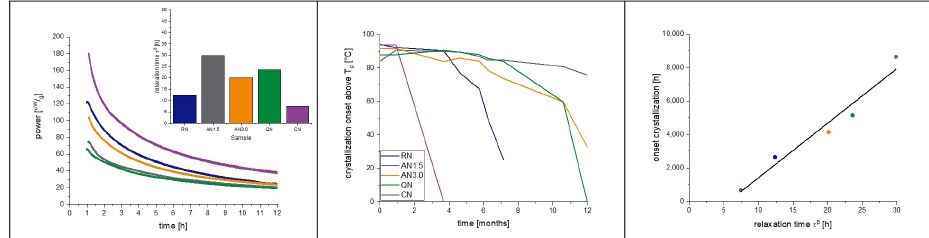
Figure 9. Samples from the 2 mgmL_1.6PS_Suc formulation at 25 °C; correlation of crystallization with α-relaxation, and the effect of the freezing step. The left picture presents a zoomed in area of the IMC measurement to focus on the relaxation curves, which are converted to a τ β -value. The middle graph shows the crystallization onset of the samples at 25 °C determined with DSC measurement using the onset of crystallization above T g . On the right, the correlation of relaxation time with crystallization onset is presented. The correlation coefficient of the fit is r 2 = 0.94. Random nucleation (blue), additional annealing step of 1.5 h (grey), additional annealing step of 3.0 h (orange), quench cooling (green), controlled nucleation (purple).